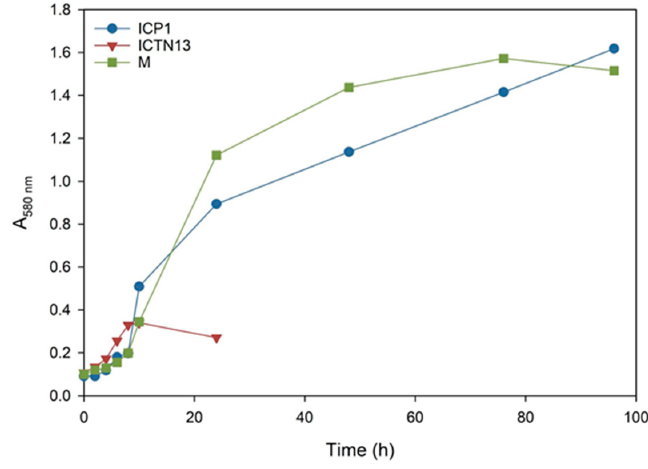
Figure 2. The growth curves of the A. venetianus strain ICP1 and P. oleovorans strain ICTN13 and the mixture of strains (M) cultivated on M9 minimal medium containing 1% crude oil at 30 °C.